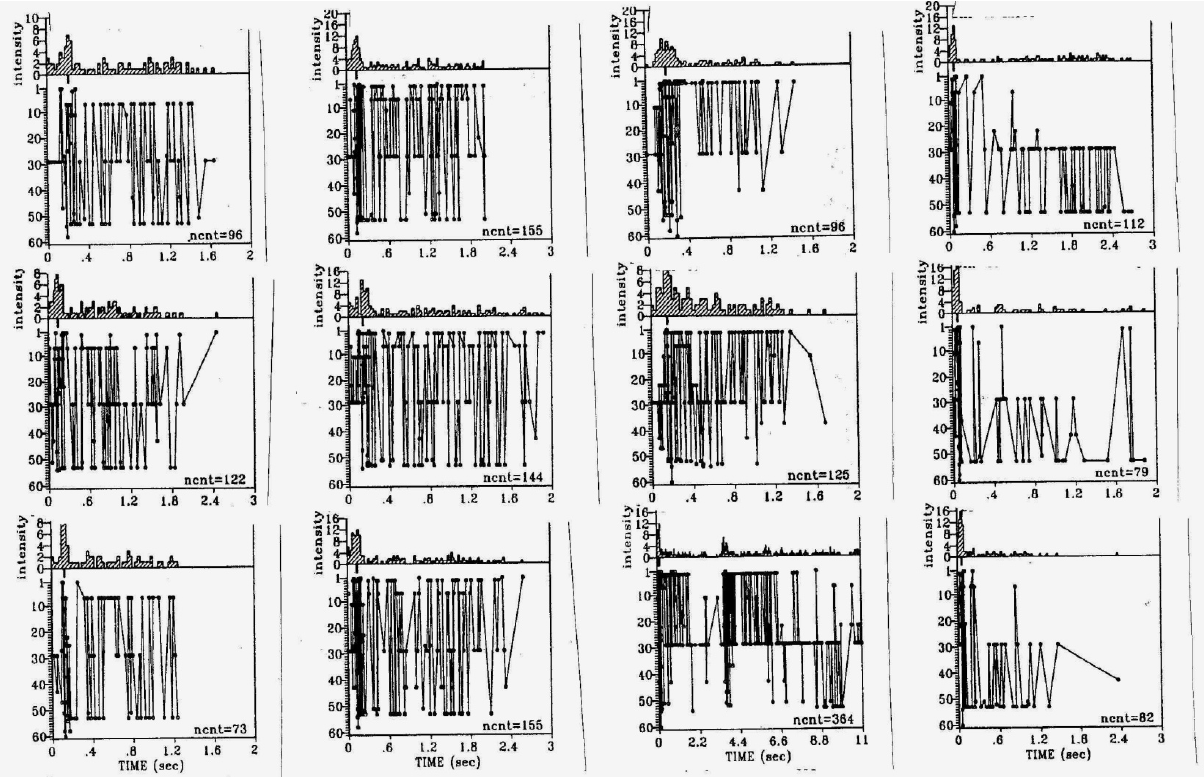
Figure 7. Examples of (four) different classes of more or less stereotyped neuronal firing in a dissociated rat neocortex culture recorded on a multi-electrode plate. The connecting lines indicate the sequential firing of individual spikes at the participating recording sites: experiment performed together with Dr. van Pelt, J. in 2005 at The Netherlands Institute for Brain Research, Amsterdam, The